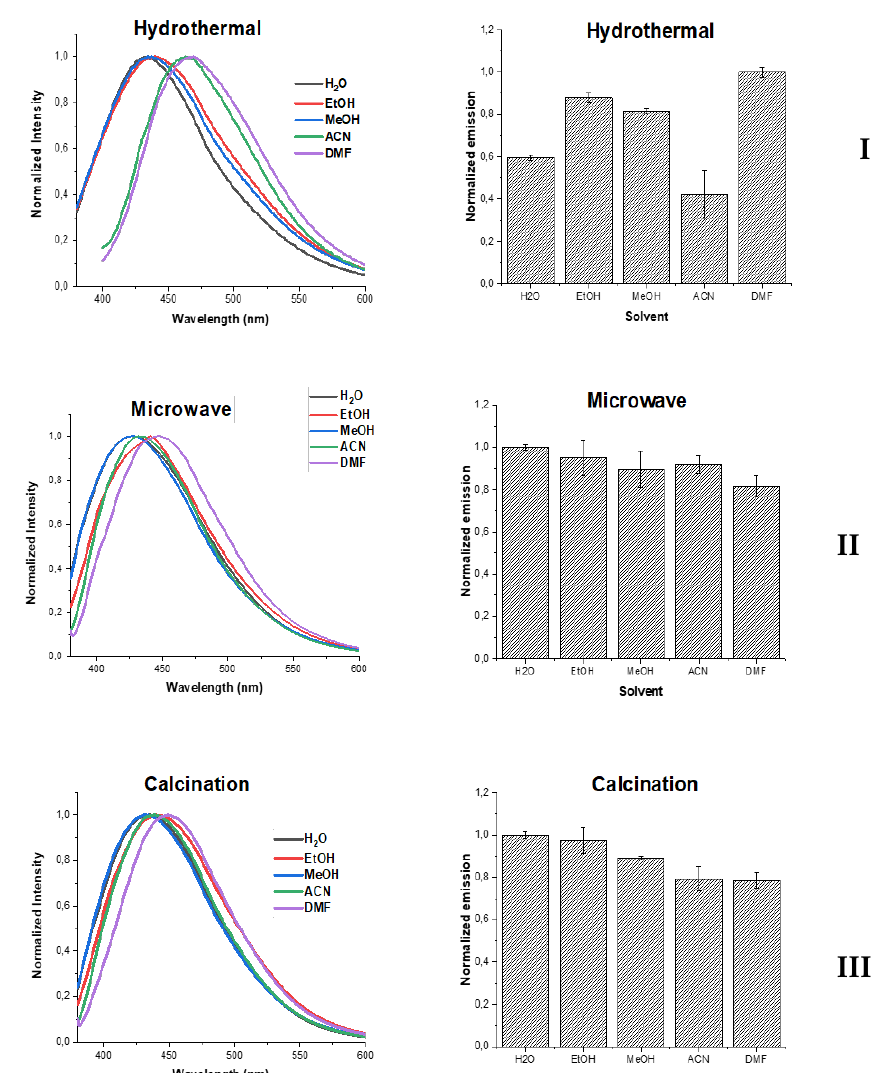
Figure 3. Normalized emission spectra for the three CDs: ( I ) hydrothermal-CDs, ( II ) microwave-CDs, and ( III )